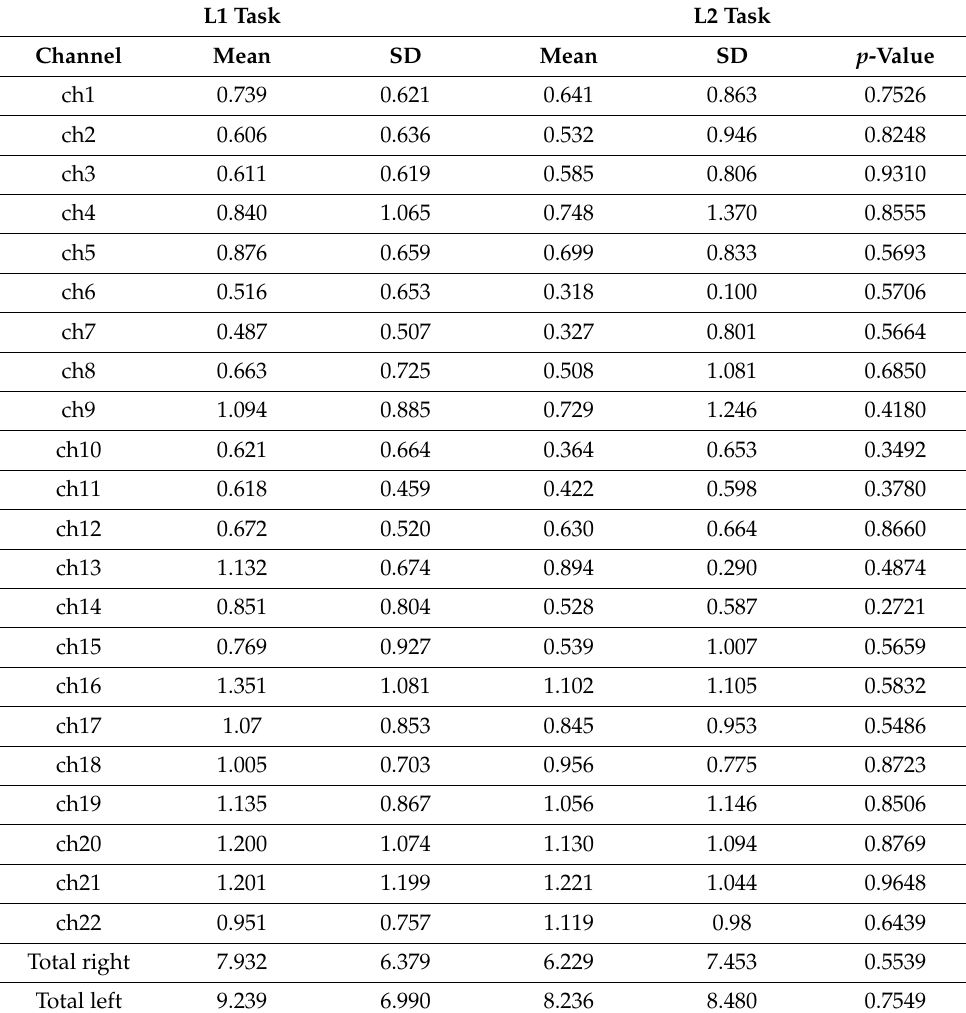
Table 3. Values of ∆ oxy-Hb at 22 channels in high-L2-ability speakers when speaking Mandarin (L1) or Japanese (L2).